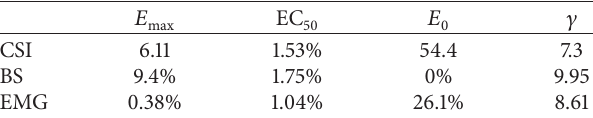
Table 2: Results from the pharmacodynamic modeling for the parameters